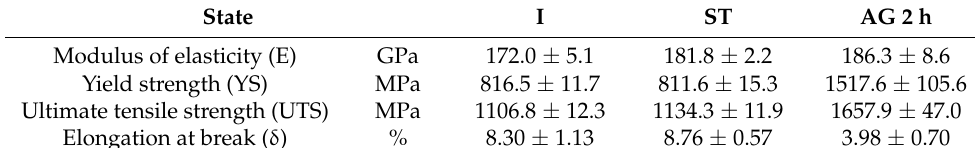
Table 4. Mechanical properties of the wrought alloy at different processing states.